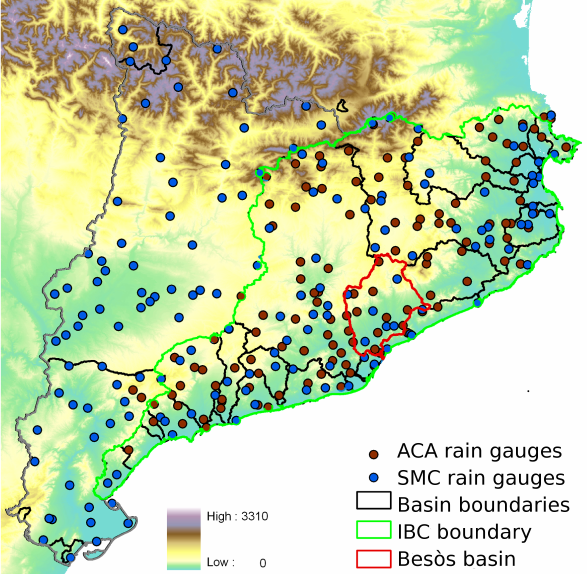
Fig. 1. Location map of Catalonia with superimposed relief and boundary information, together with SAIH (ACA) and XEMA (SMC) raingauge